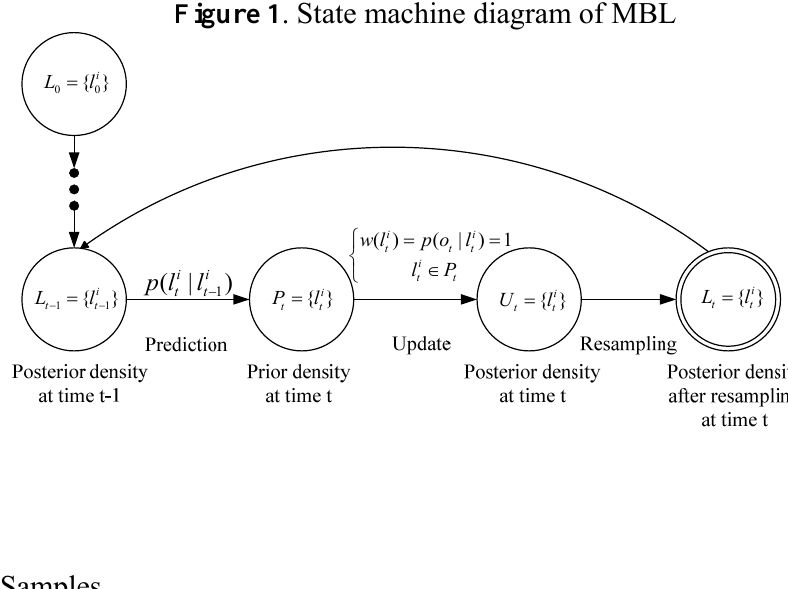
Figure 1 . State machine diagram of